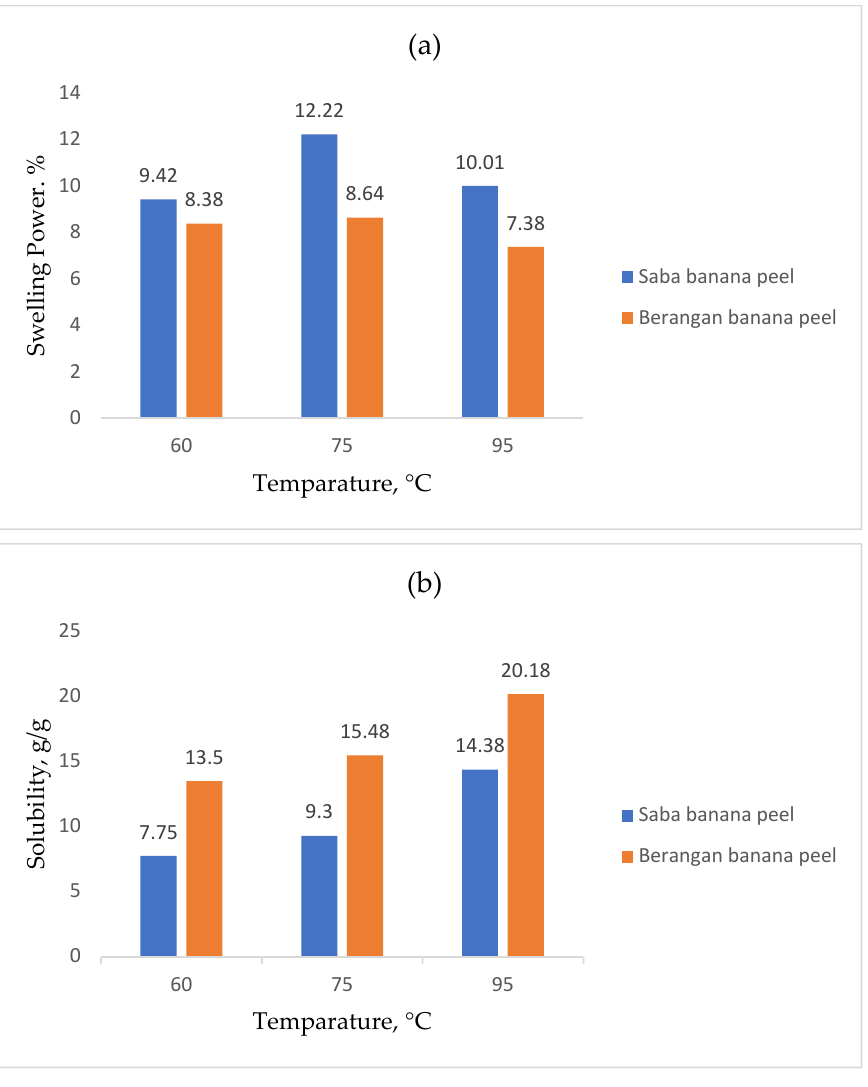
Figure 1. ( a ) Swelling power and ( b ) water solubility of banana peel